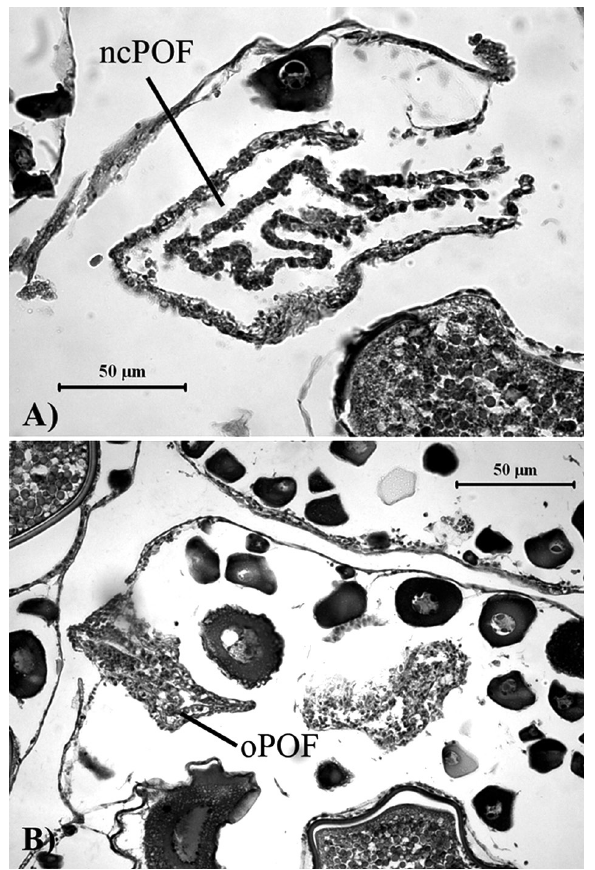
f ig . 2. – Serranus scriba. Classification of post-ovulatory follicles (POFs) used in the present study: newly collapsed POFs (ncPOFs) (A) and old POFs (oPOFs)